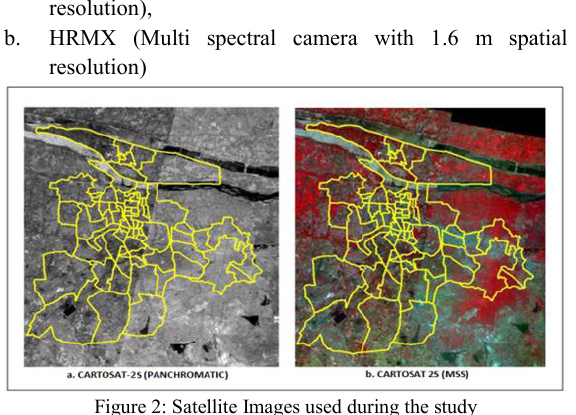
Figure 2: Satellite Images used during the study